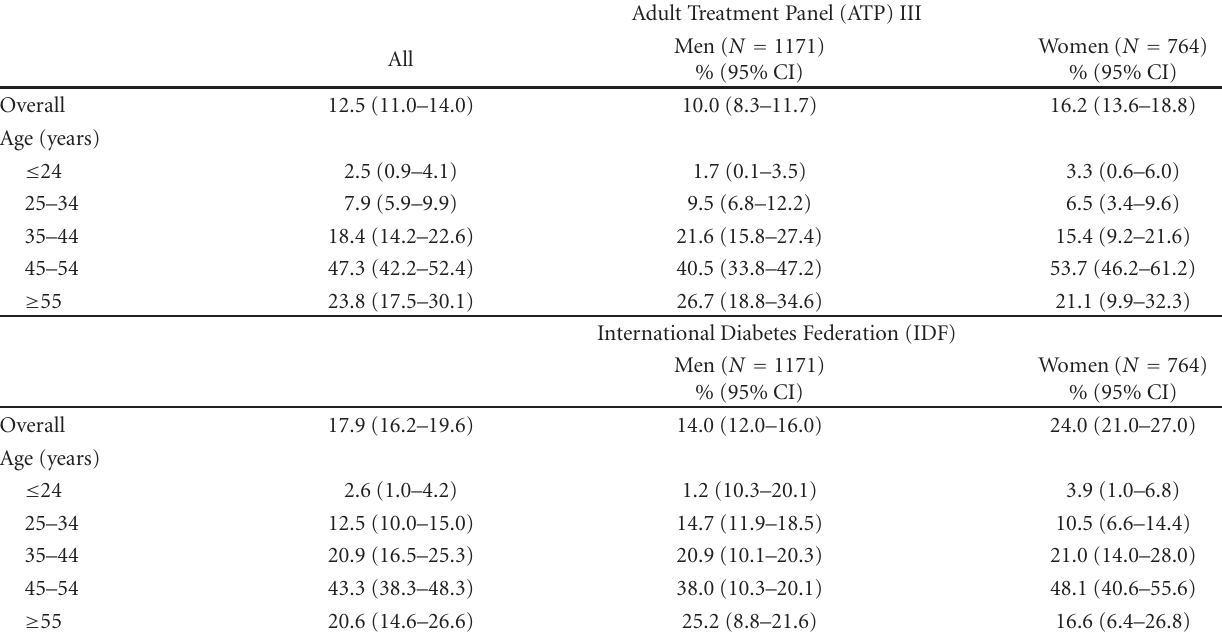
Table 3: Prevalence of metabolic syndrome based on di ff erent sets of criteria by age